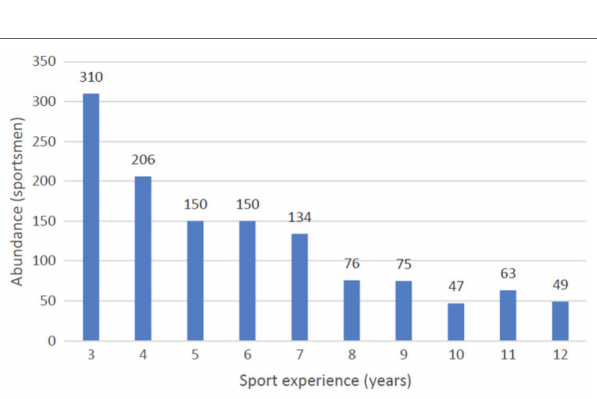
FIGURE 2 | Distribution athlete groups regarding the sport experience measured in years.